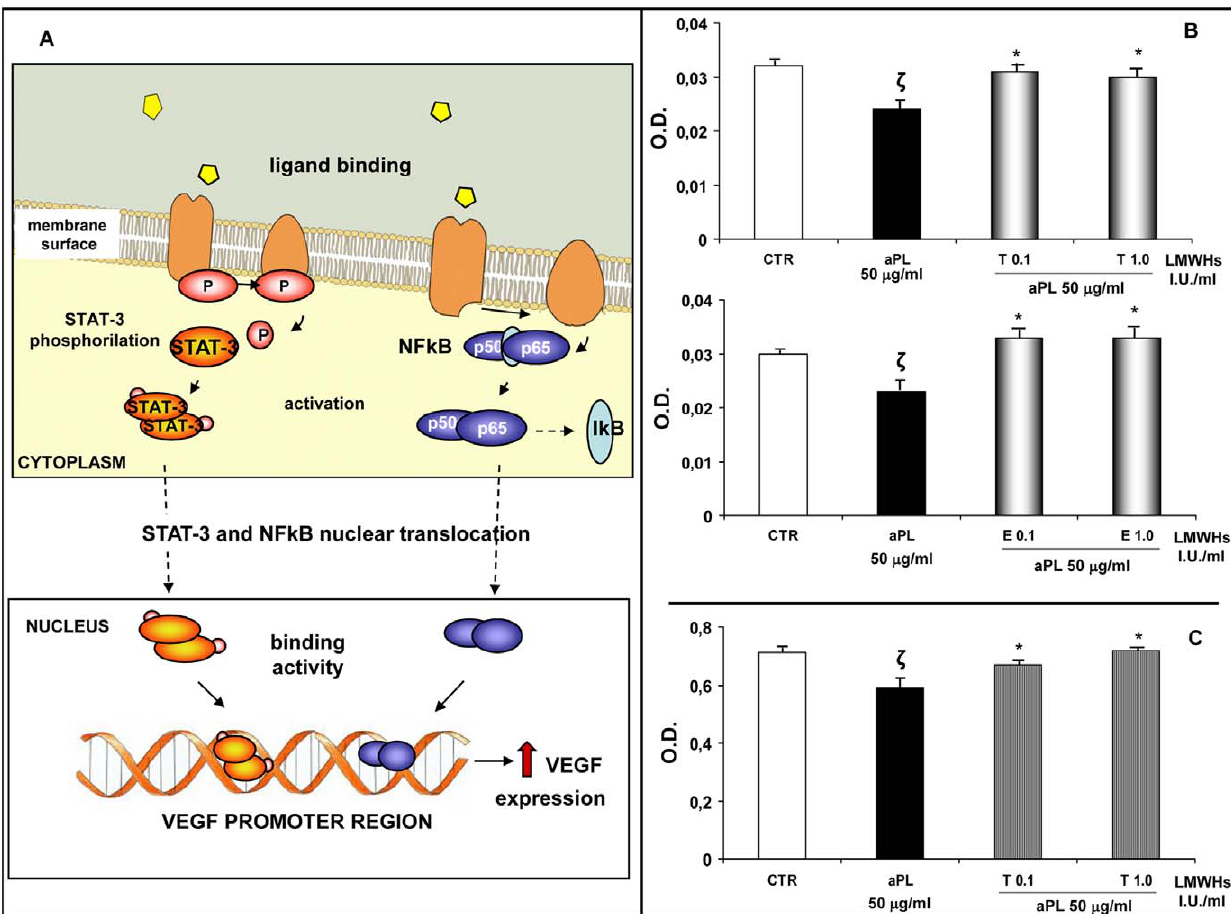
Figure 3. Intracellular mechanisms regulating VEGF expression in HEEC. Effects of aPL and LMWHs on NF- k B and STAT-3 activation. A. VEGF is a well-known factor able to promote endothelial cell proliferation and new vessel formation. Several intracellular mechanisms regulate VEGF expression in HEEC including NF-kB and STAT-3. The figure illustrates these two signalling pathways whose activation increases VEGF expression. NF- k B activity is regulated by the interaction with the inhibitory I k B protein. Upon activation, IkB is phosphorylated and degraded, thus allowing NF- k B to translocate into the nucleus and bind to VEGF promoter region, upregulating the expression of this proangiogenic factor by HEEC. Moreover STAT-3 is a member of JAK-STAT signalling pathway. It is a latent transcription factor which is activated by phosphorylation. Activated STAT-3 protein induces its nuclear translocation and favours VEGF expression. B. NF- k B activation in the presence of aPL alone or with tinzaparin or enoxaparin after 4 hrs of treatment in differentiation culture medium. aPL reduced NF- k B activation while tinzaparin or enoxaparin were able to restore the NF- k B DNA binding activity. The values are O.D. mean 6 SE of three different experiments. CTR: untreated cells; T: tinzaparin; E: enoxaparin; O.D.: Optical Density; f : P , 0.01 compared with CTR; *: P , 0.001 compared with aPL-treatment. C. Effects of aPL on STAT-3 phosphorylation in the presence of tinzaparin after 4 hrs of treatment in differentiation culture medium. aPL reduced STAT-3 activation while tinzaparin was able to restore the STAT-3 phosphorylation. Values are O.D. means 6 SE of three different experiments. CTR: untreated cells; T: tinzaparin; O.D.: Optical Density; f : P , 0.05 compared with CTR; *: P , 0.05 compared with aPL treatment.